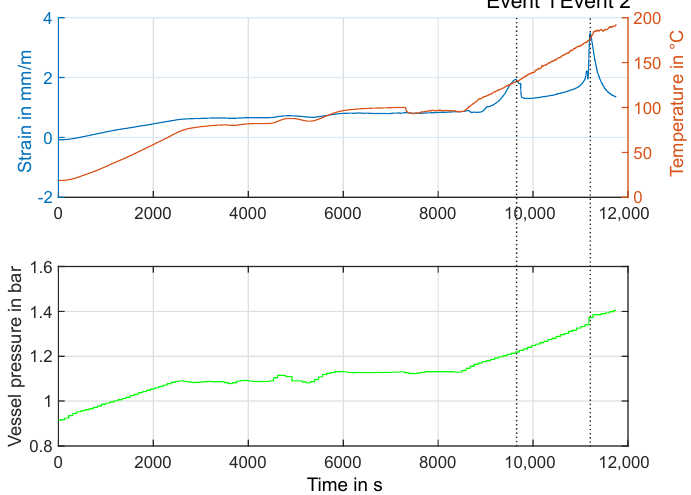
Figure 13. Experiment HT2: Behavior of cell temperature and strain, as well as air pressure in